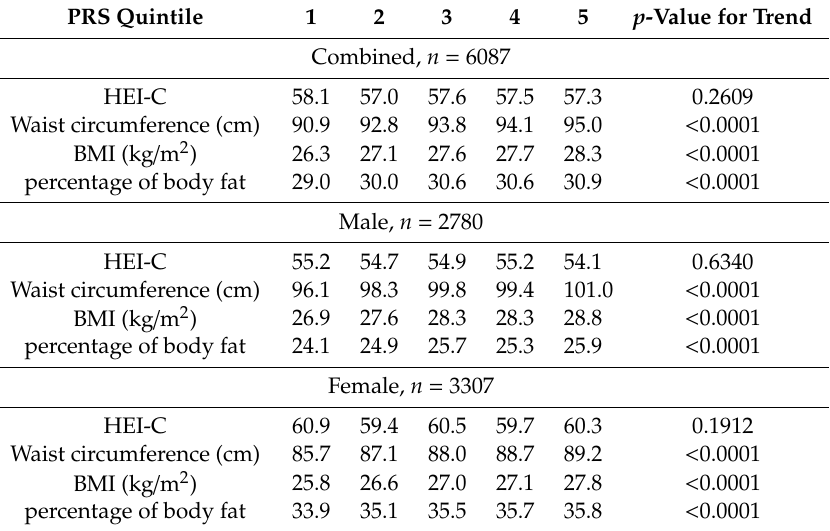
Table 3. Mean and standard deviation of HEI-C, waist circumference, body mass index (BMI), and percentage of body fat by polygenic risk score (PRS) quintile among diet sample. PRS